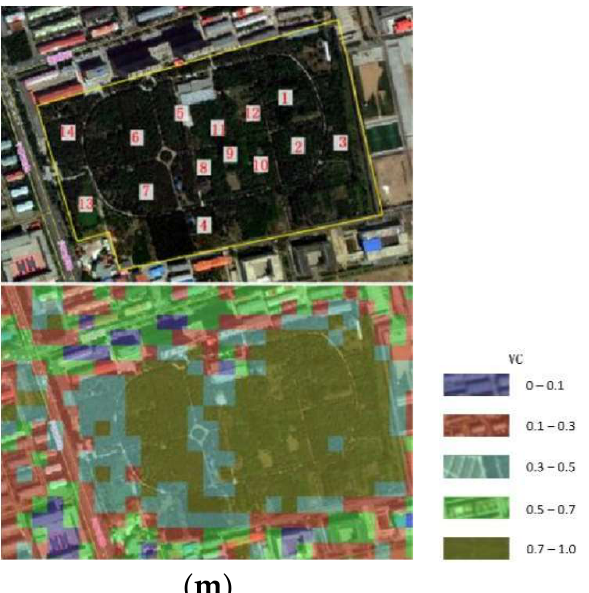
Figure 4. ( a – m ) Mapping of VC in sample areas and the location diagram of the sample plot in the sample area.